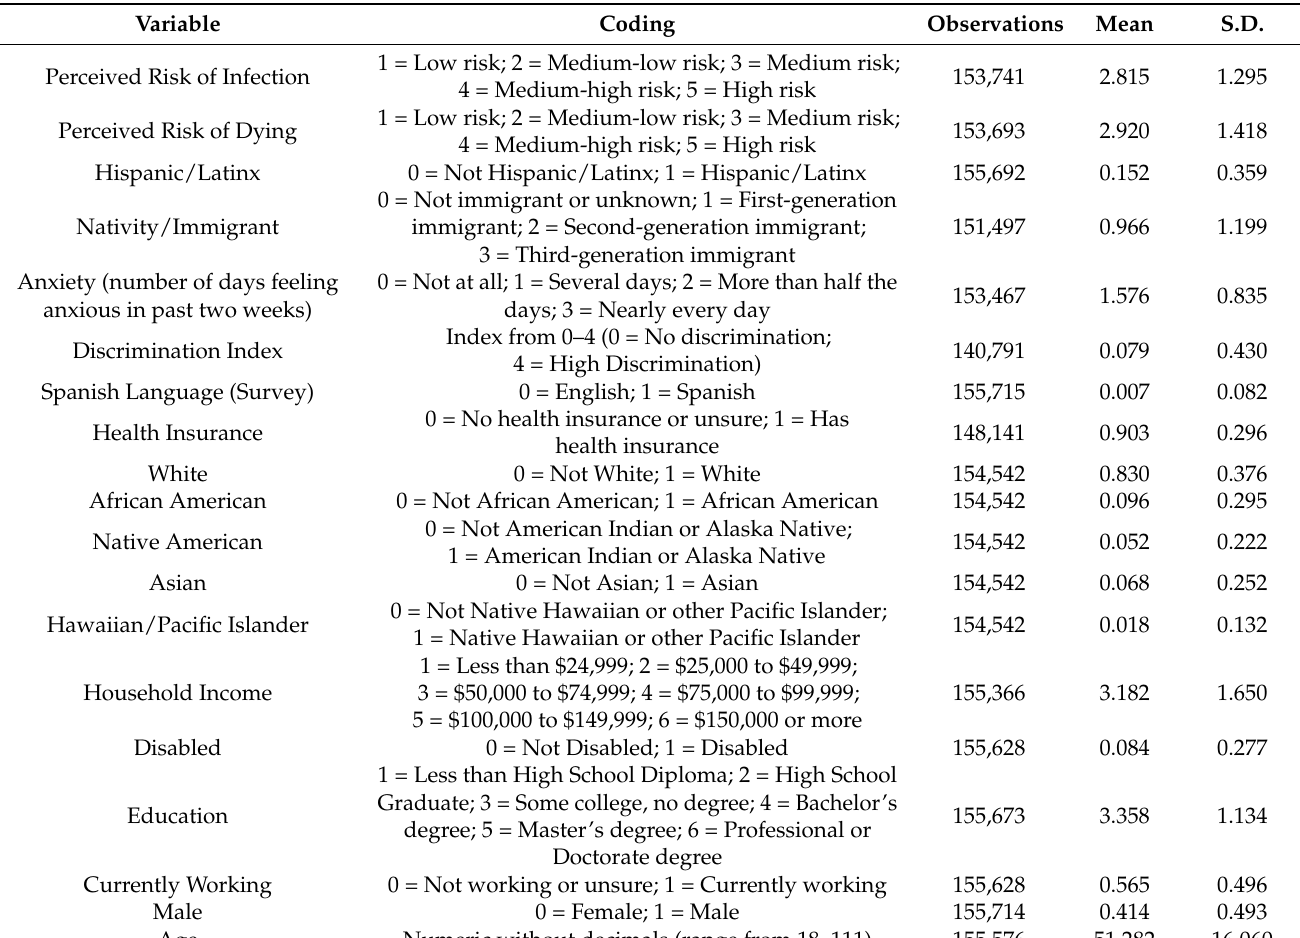
Table 1. Descriptive